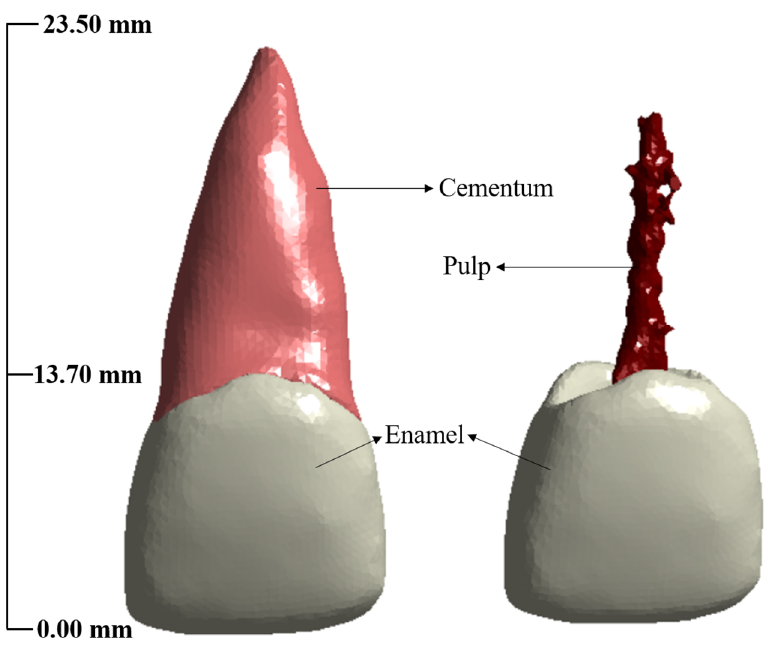
Figure 1. Constituents of tooth showing root, enamel, and pulp.